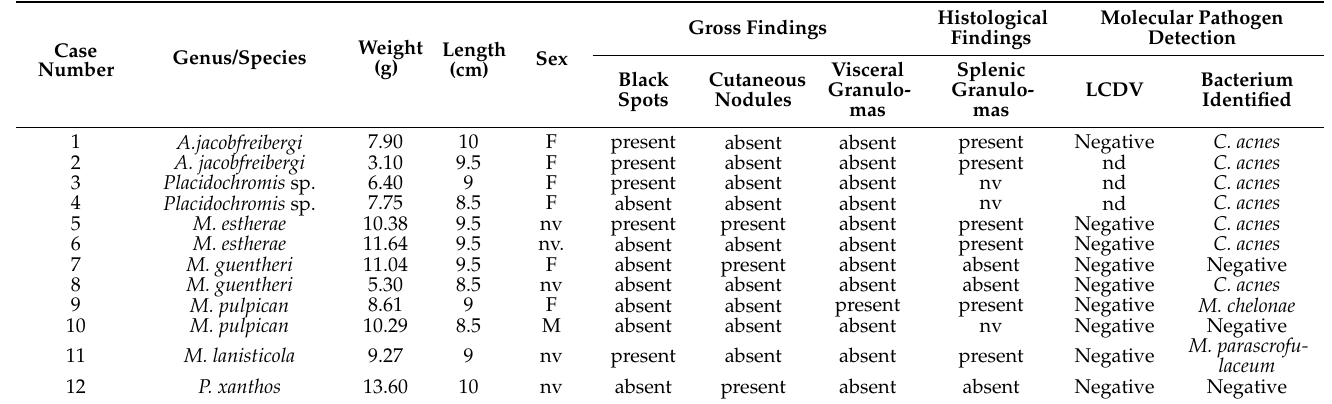
Table 1. Synoptic table of ornamental fish species investigated in this study.